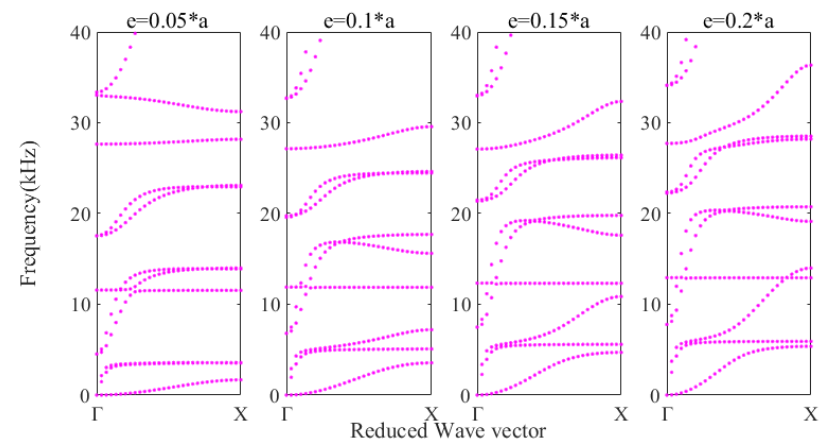
Figure 7. The influence of plate thickness e on the dispersion curve of the HPFC.